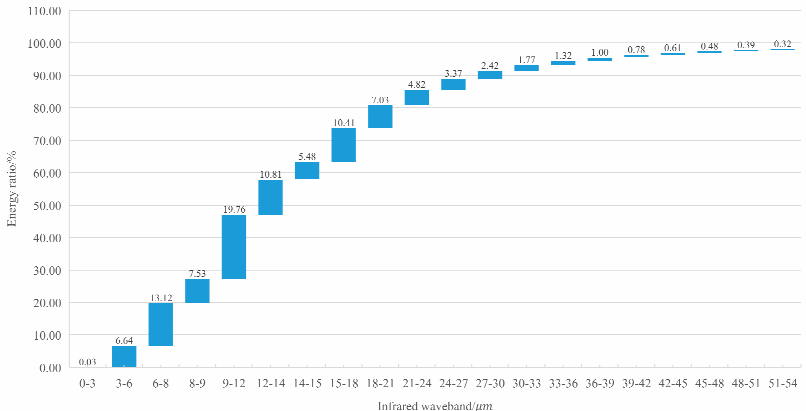
Figure 13. Distribution of radiant energy in different infrared waveband.